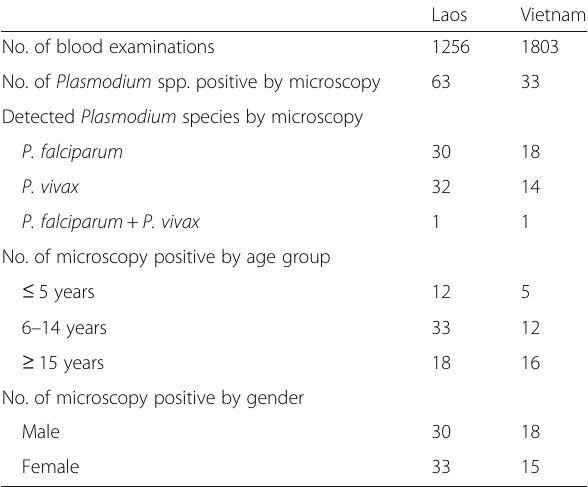
Table 1 Number of samples for this study and results